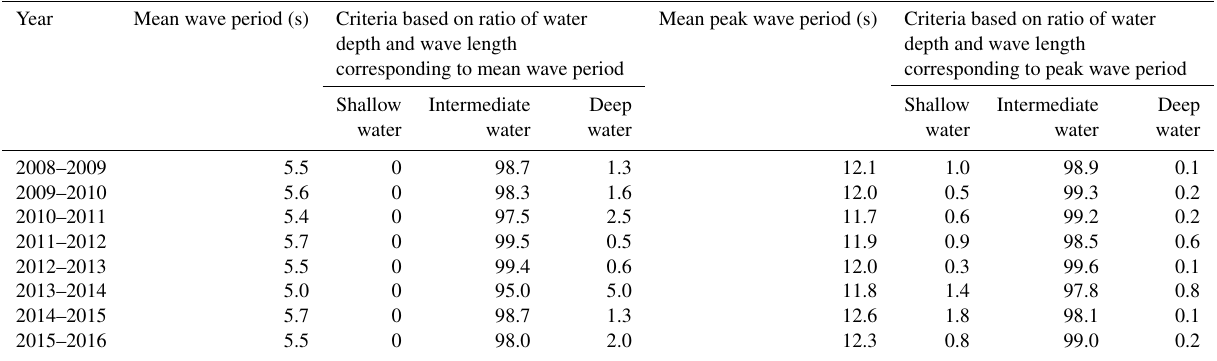
Table 7. The percentage of time of the waves in the shallow, intermediate and deep water regime in different years along with the mean wave period and mean peak wave period. Mean peak wave period (s) Criteria based on ratio of water Year Mean wave period (s) Criteria based on ratio of water depth and wave length depth and wave length corresponding to peak wave period corresponding to mean wave period Shallow Intermediate Deep Shallow Intermediate Deep water water water water